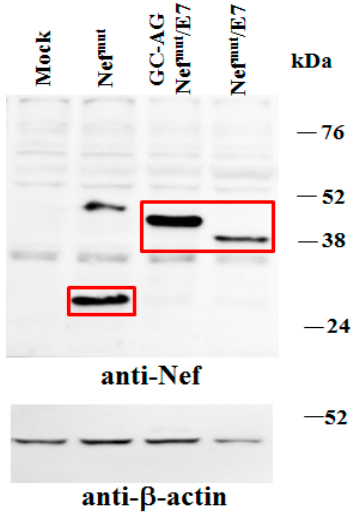
Figure 3. Analysis of expression of GC-AG Nef mut / E7. Western blot analysis of total cell lysates from HEK-293T cells transfected with DNA vectors expressing the indicated Nef mut -based fusion products. As control, conditions from mock-transfected cells, as well as cells transfected with Nef mut , were included. Polyclonal anti-Nef Abs served to detect Nef mut -based products, while β -actin levels were detected as a reference standard. Nef-specific signals are highlighted. Molecular markers are given in kilodaltons (kDa). Signal intensity ratios compared to the Nef mut control condition, considering the respective -actin signals, were 1.48 and 1.43 for GC-AG Nef mut /E7 and Nef mut /E7, respectively. The results are representative of five independent experiments. Uncropped blots showing all the bands with all molecular weight markers are shown in Supplementary Figure S1. The intracellular stability of the two fusion products was assessed by treating cells with cycloheximide to halt their synthesis after DNA transfection, and evaluating the amounts of the two products over time by Western blot analysis. We observed the disappearance of both Nef mut /E7 and GC-AG Nef mut /E7 signals 48 h after cycloheximide treatment (Figure 4), indicating that the kinetics of intracellular degradation of the two fusion products was similar. This result supports the idea that the lack of N-terminal fatty acids does not affect the overall stability of Nef mut /E7.